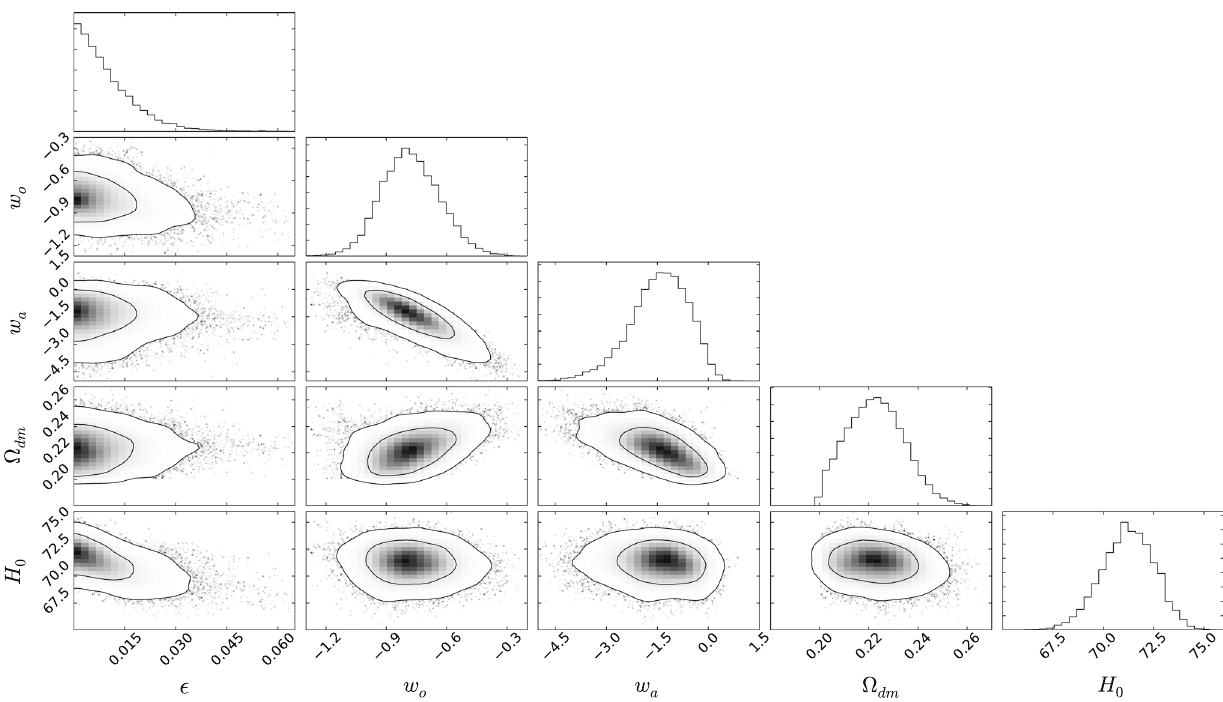
Fig. 1 The results of our statistical analysis. Confidence contours (68.3% and 95.4%) and the posterior distribution for the cosmological parameters assuming P1 and considering the Gaussian prior H 0 = 73 . 52 ± 1 . 62 km s − 1 Mpc − 1